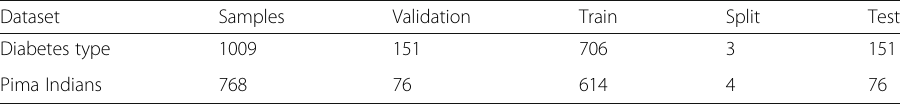
Table 3 Data Preprocessing: separation Dataset